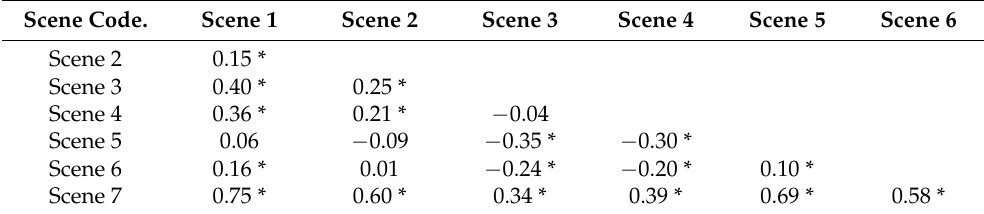
Table 3. Values and standard deviations for all spatial scenes. Scene Code.